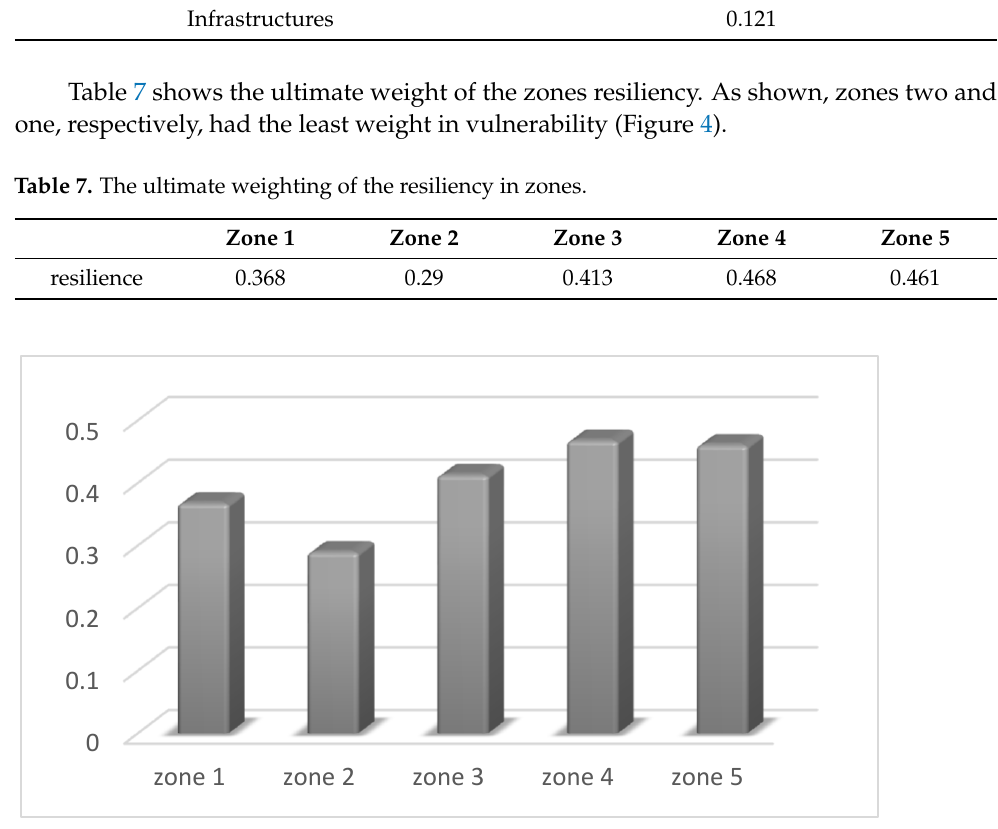
Figure 4. The ultimate weighting of the resiliency in zones.